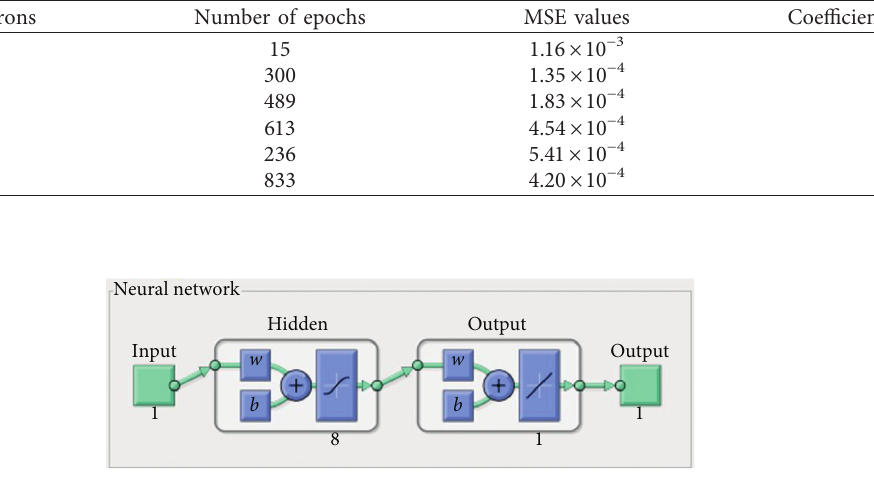
Figure 3: Architecture of the designed NN.